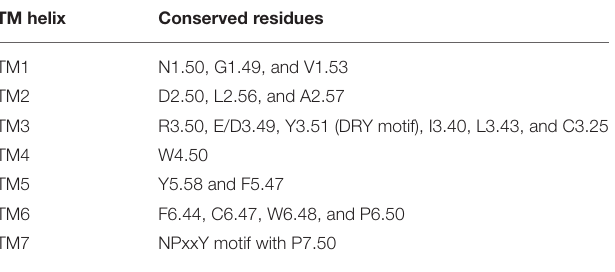
TABLE 1 | Conserved residues in each of the TM helices in rhodopsin family [44]. TM